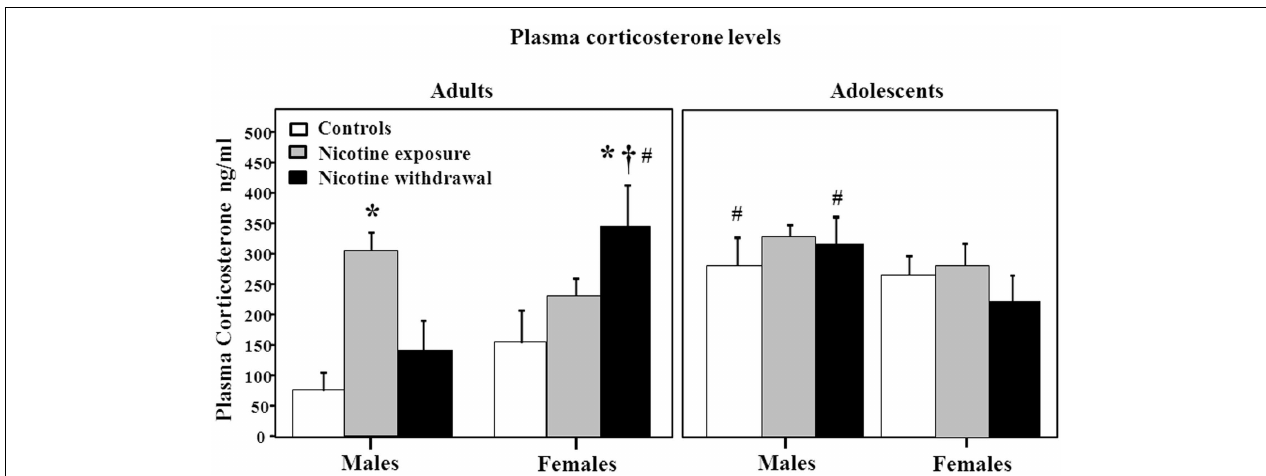
(control n = 6; nicotine exposure n = 5; nicotine withdrawal n = 5) rats . The asterisks (*) denote a significant difference between nicotine-treated male and female adult rats and their respective controls, the dagger (†) denotes a significant difference between males and females, and the number signs (#) denote a significant difference between adolescents and adults ( P < 0.05).